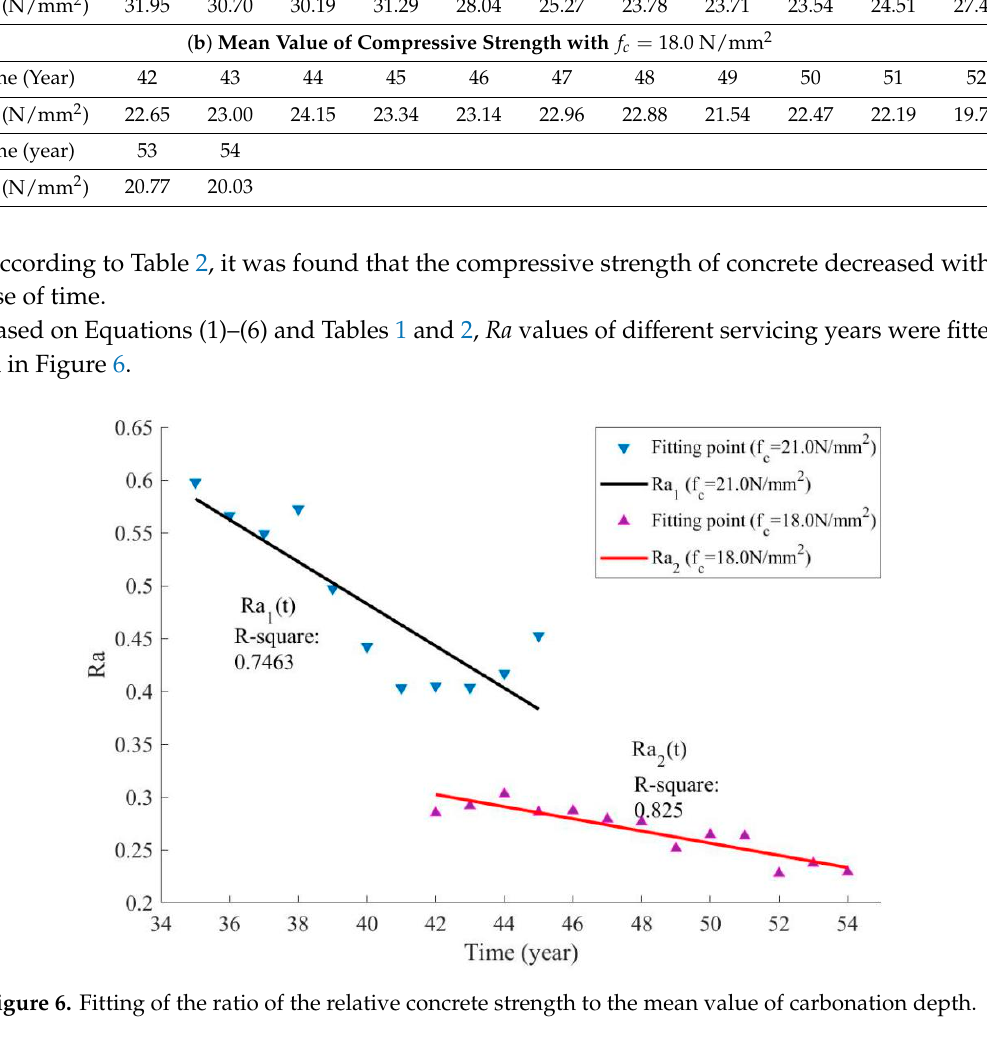
Table 2. Mean value of compressive strength with ( a ) f c = 21.0 N/mm 2 and ( b ) f c = 18.0 N/mm 2 .